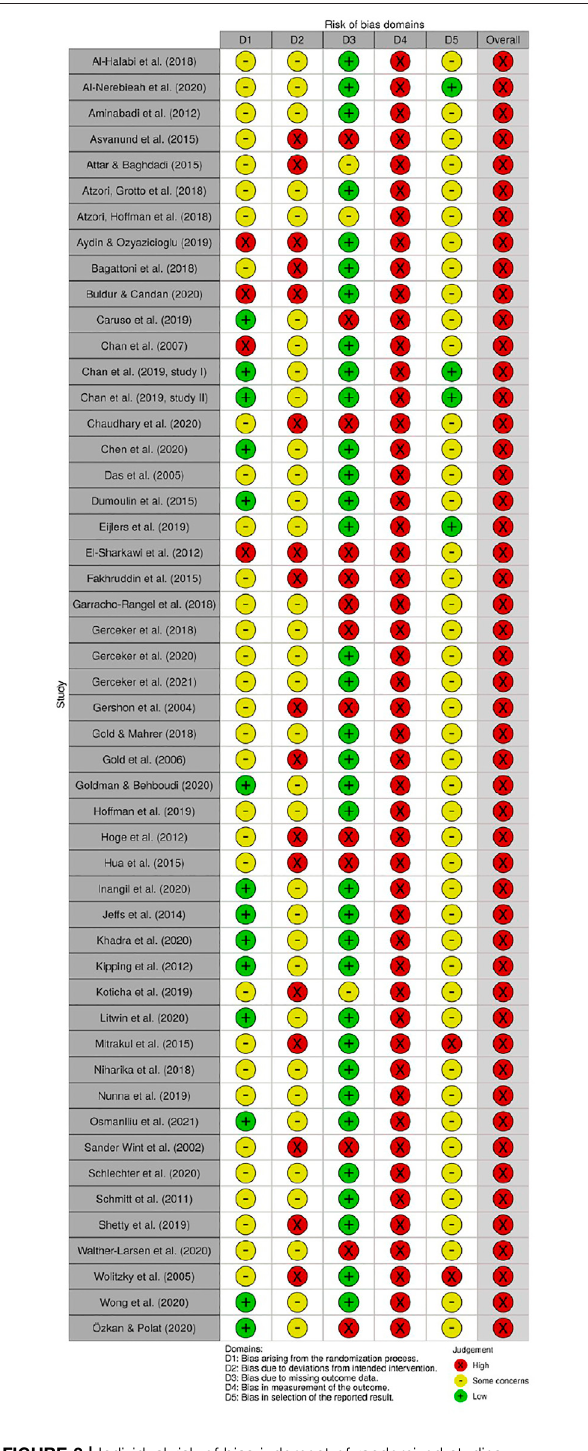
FIGURE 3 | Individual risk of bias judgment of randomized studies reporting pain outcomes.